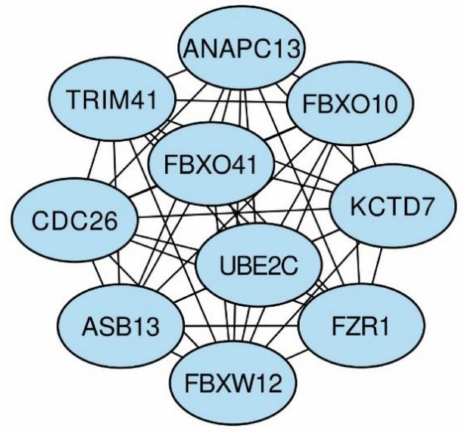
Figure 3. The networks of the top 10 hub